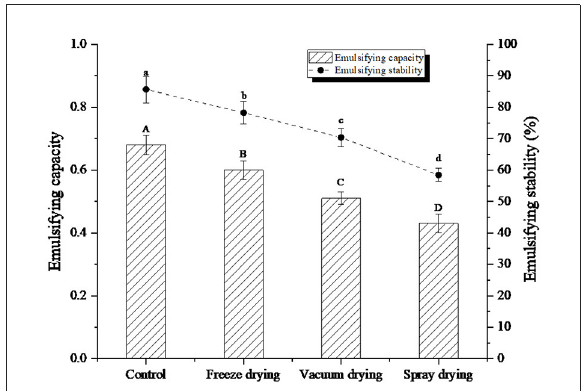
FIGURE4 Emulsifying capacity and emulsifying stability of protein peptide powder by three dry methods. Different letters express significant differences ( p <